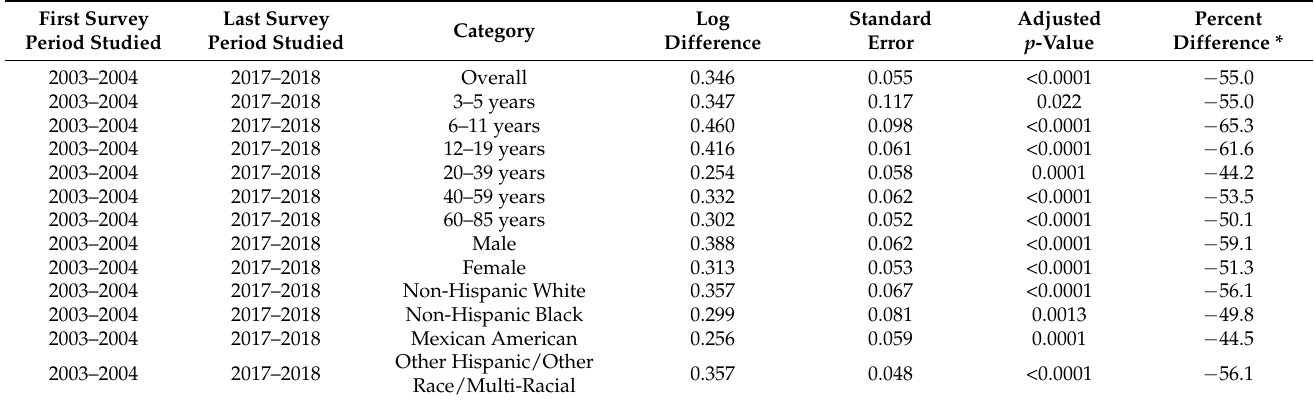
Table A3. Weighted Detection rates for serum cotinine by NHANES survey cycle overall and for each demographic subgroup from 2003 to